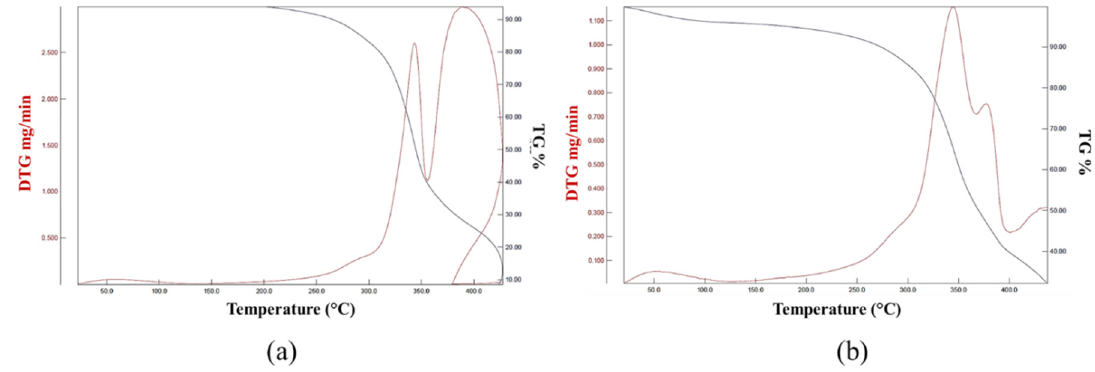
Figure 6. TGA analysis of mixture resin composites: ( a ) DS/KEFL; ( b ) DS/23BA/KEFL.